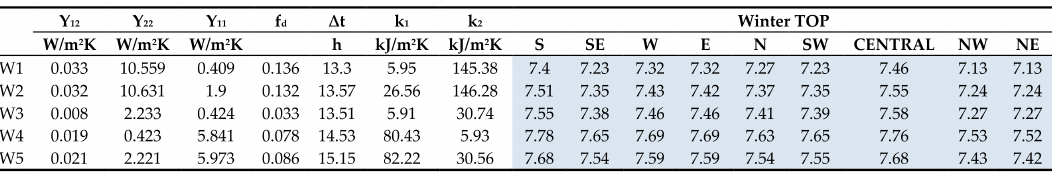
Table 12. TOP analysis for the Combo